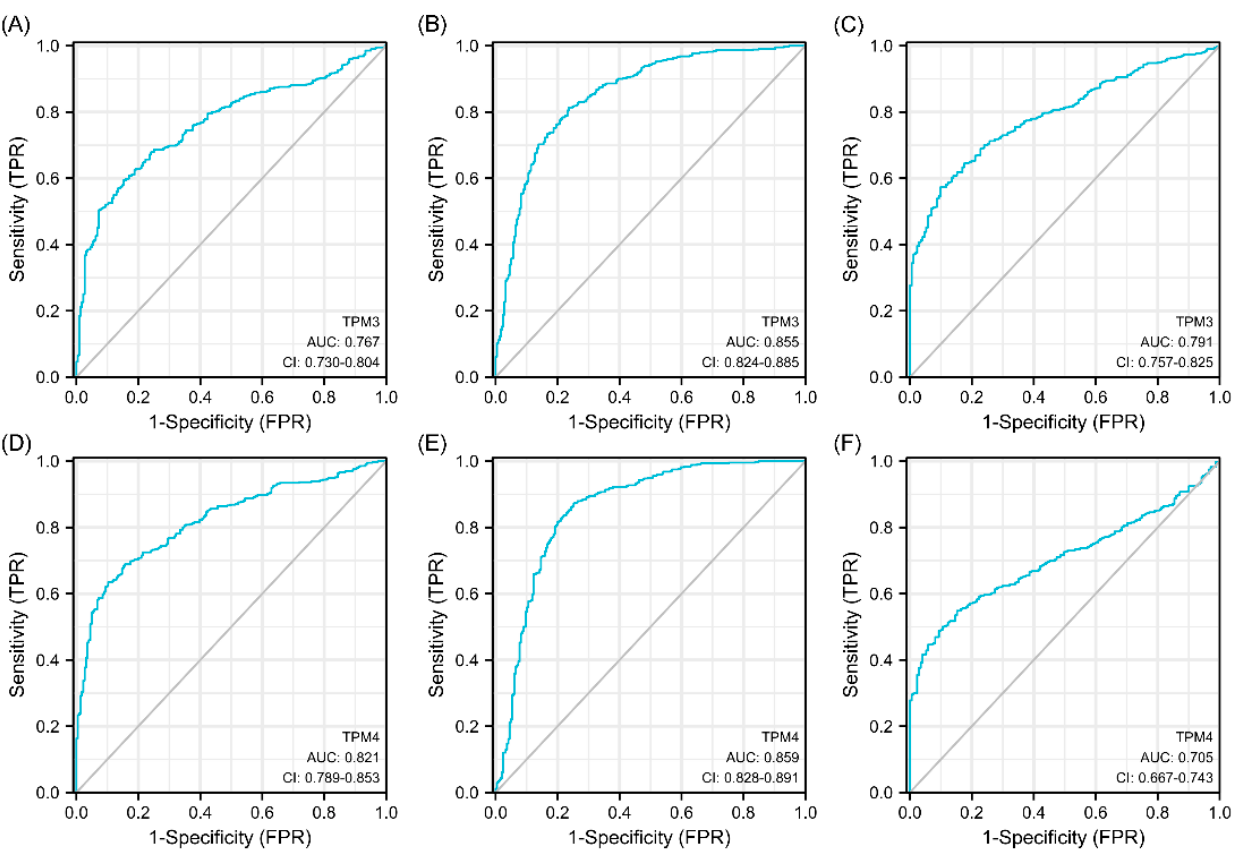
Figure 7. Diagnostic value of TPM3 and TPM4 in glioma. ( A ) The diagnostic value of TPM3 mRNA expression for the WHO grade. ( B ) The diagnostic value of TPM3 mRNA expression for the IDH status. ( C ) The diagnostic value of TPM3 mRNA expression for the 1p/19q status. ( D ) The diagnostic value of TPM4 mRNA expression for the WHO grade. ( E ) The diagnostic value of TPM4 mRNA expression for the IDH status. ( F ) The diagnostic value of TPM4 mRNA expression for the 1p/19q status.